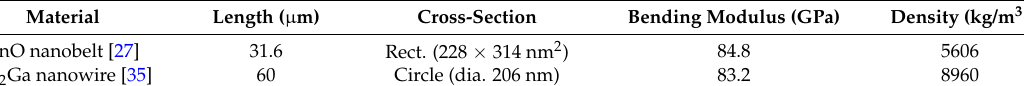
Table 1. Properties of ZnO nanobelt and Ag 2 Ga nanowire.